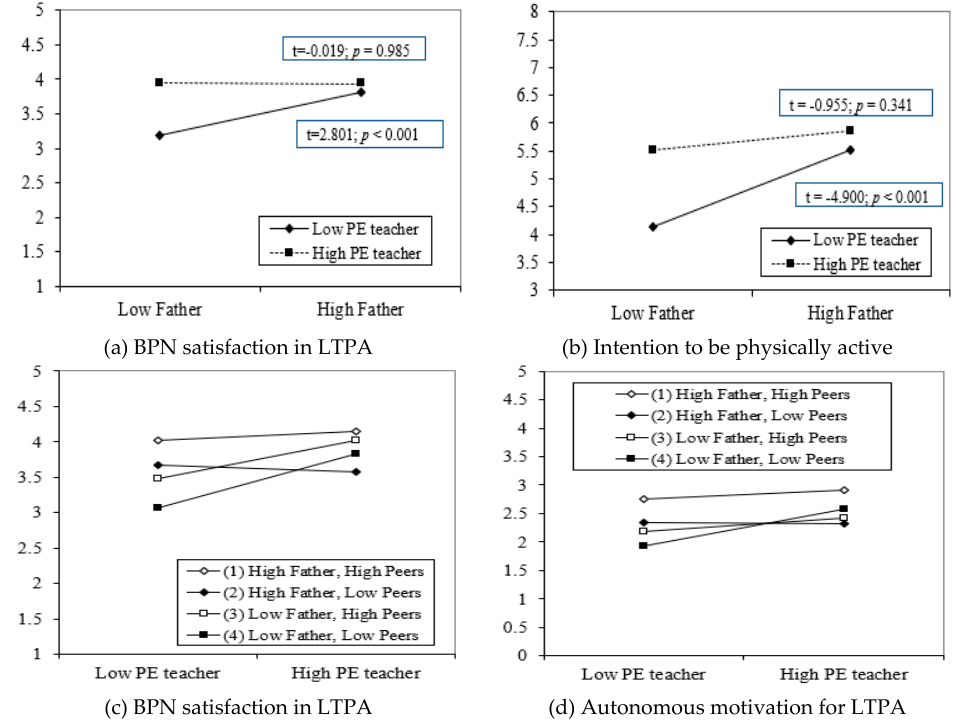
Figure 1. Note 1: Moderation effect between autonomy support from the PE teacher and father in predicting: ( a ) BPN satisfaction in LTPA and ( b ) intention to be physically active (two ‐ way interaction with continuous moderator). Note 2: Moderation effect between autonomy support from the PE teacher, father, and peers in predicting: ( c ) BPN satisfaction in LTPA and ( d ) autonomous motivation for LTPA (three ‐ way interaction with continuous moderators).